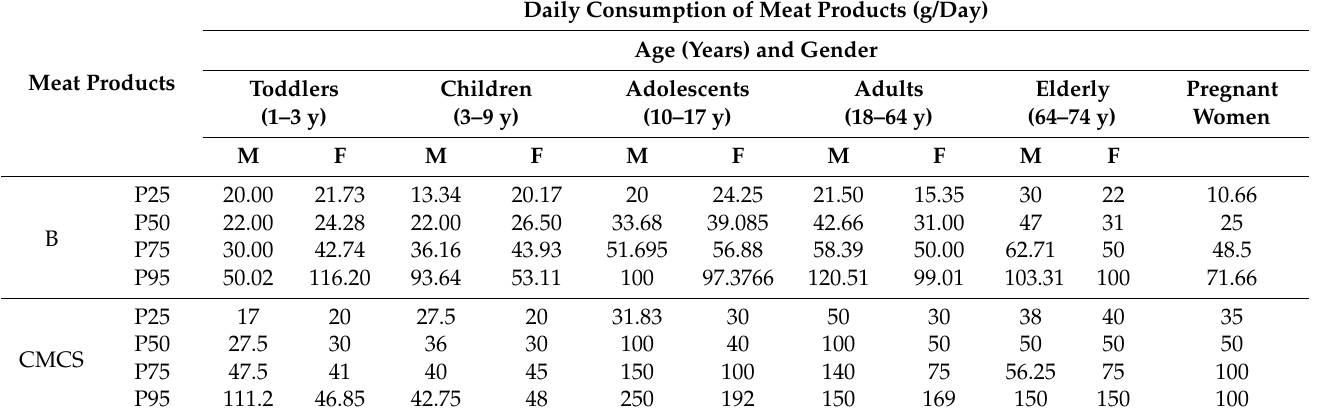
Table 2. Distribution of consumption (g/day) of meat products by populations (age and